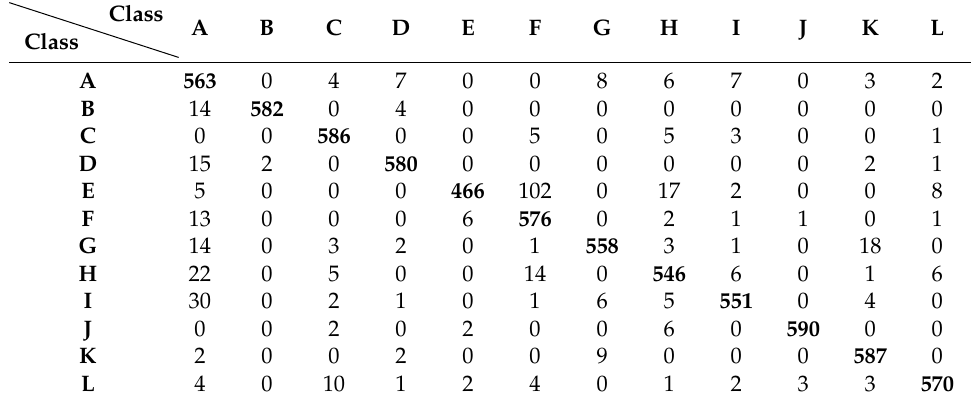
Table 6. Classification results after combination using Borda count procedure using weight.